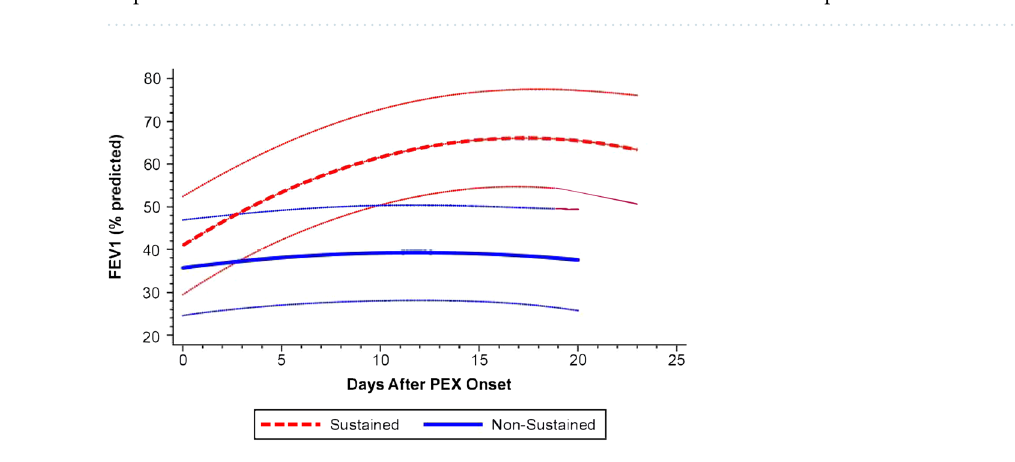
Figure 2. Trends in CFRSD-CRISS during PEX treatment. “Spaghetti plots” of raw CFRSD-CRISS data identified a cohort with a sustained decline in symptom burden ( a ) and a cohort with an initial decline and terminal rebound in symptom burden ( b ). These distinctions were modeled using a linear mixed model ( c ), adjusting estimates for any difference in CFRSD-CRISS between sustained and non-sustained symptom responders at PEX onset. Curves around each estimated trend reflect 95% C.I. of parameter estimates.